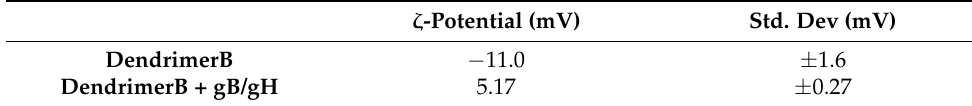
Table 2. ζ -Potential measurement of DendrimerB and DendrimerB + Table 2. ζ-Potential measurement of DendrimerB and DendrimerB+gB/gH.